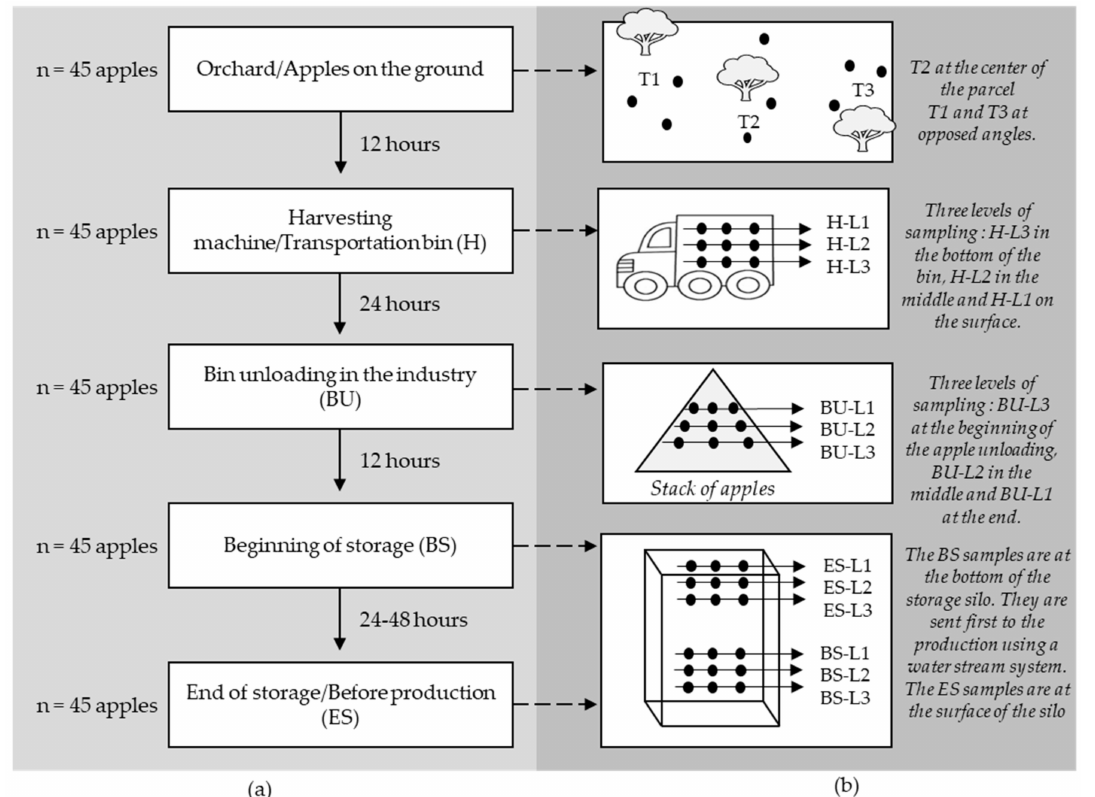
Figure 1. ( a ) Flow diagram of the different sampling steps of the cider processing chain with the number of apples sampled and the period between two consecutive steps. ( b ) Sketches of each sampling step with an illustration of the general location of selected apples. Each black dot represents a sample composed of fives apples picked randomly. The sketches are just for illustration purposes and do not reflect the exact location of the